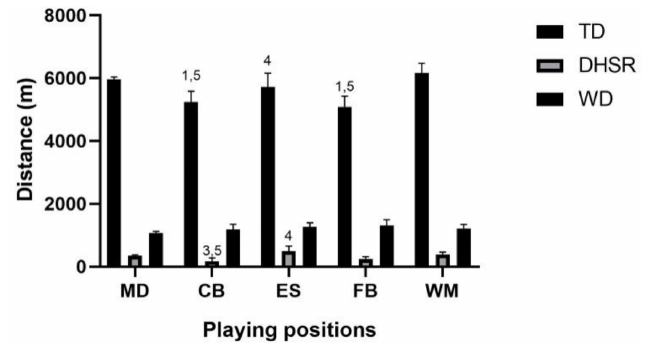
Figure 1. Playing position’s cinematic indicators (TD, DHSR, WD) during the first half of official matches. Legend: TD, Total Distance; MS, WD, Walking Distance; DHSR, Distance High-Speed Running; MD, midfielder; CB, central back, ES, external striker, FB, fullback, WM, wide midfielder; p < 0.05 for differences between playing positions (1 difference with midfielder; 3 difference with external striker; 4 difference with full back; 5 difference with wide midfielder).